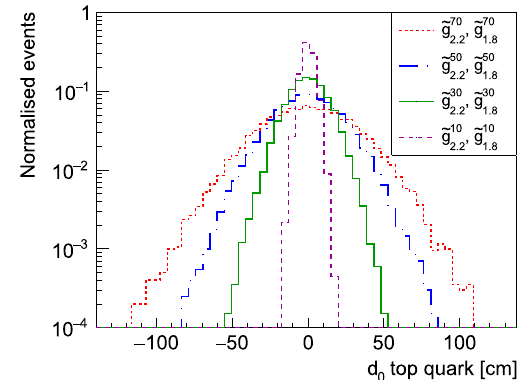
Fig. 71 Transverse impact parameter d 0 distributions for the eight benchmarks with a magnetic field of B = 3 . 8 T